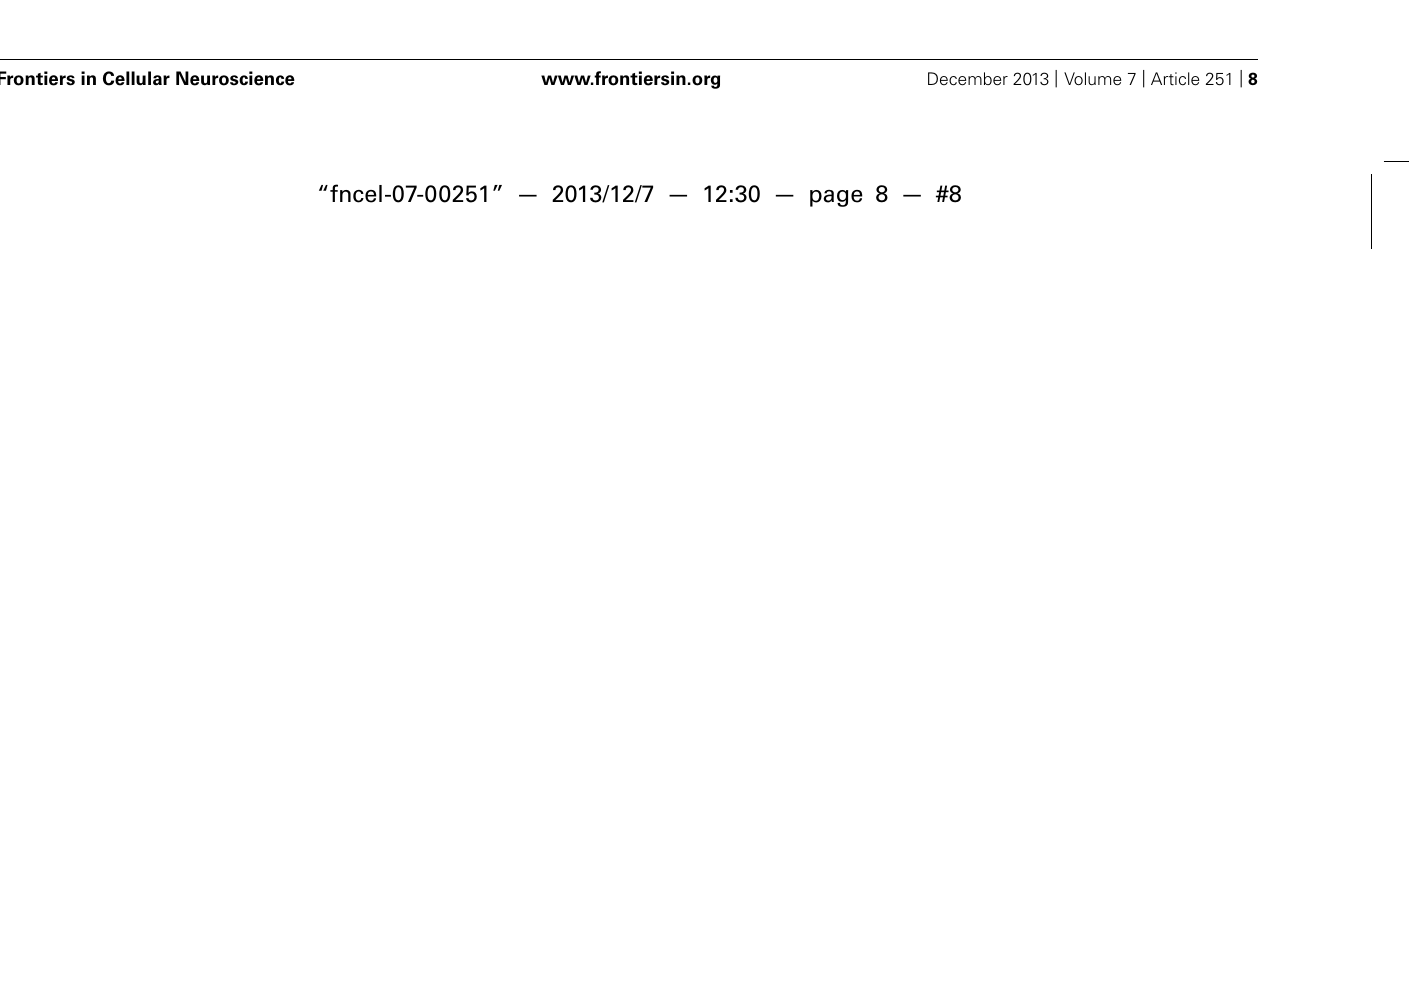
FIGURE 6 | Following peripheral nerve injury, astrocytes are the source of PKC- δ activation. (A) Schematic showing the region of interest in the spinal dorsal horn. (B) Immunofluorescence highlighting spinal GFAP immunoreactivity one week after sham (left picture) or in SNI surgery (right picture). Scale bar 100 μ m. (B,C) Immunofluorescence detecting isoforms of phospho PKC. (C) A colocalization is found between markers for